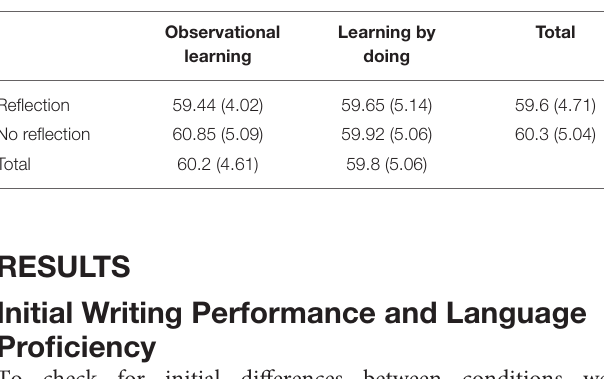
TABLE 5 | Mean Scores (SD) on Language Proficiency Test (min. score 0, max. score 75) per condition.